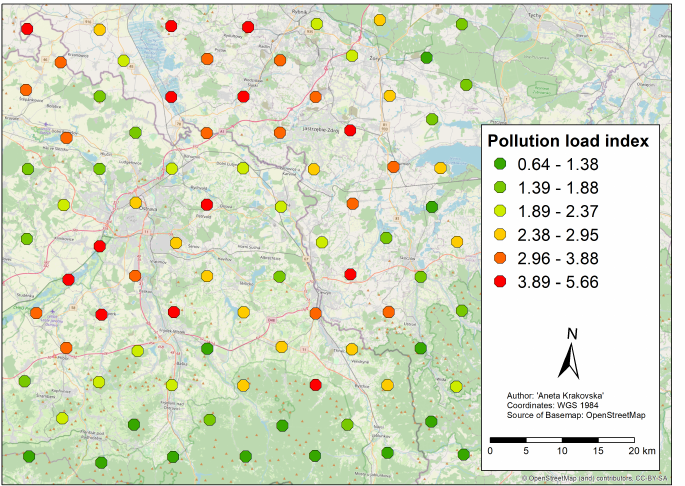
Figure 11. Pollution load